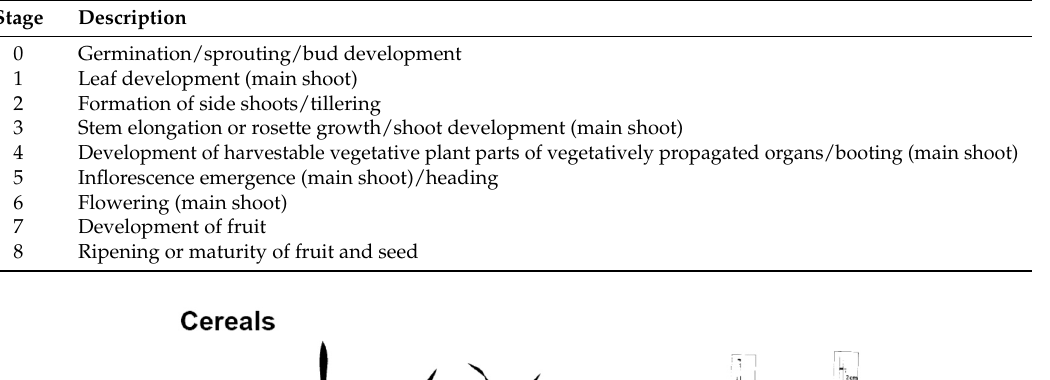
Table 1. Principal growth stages of crops [10].